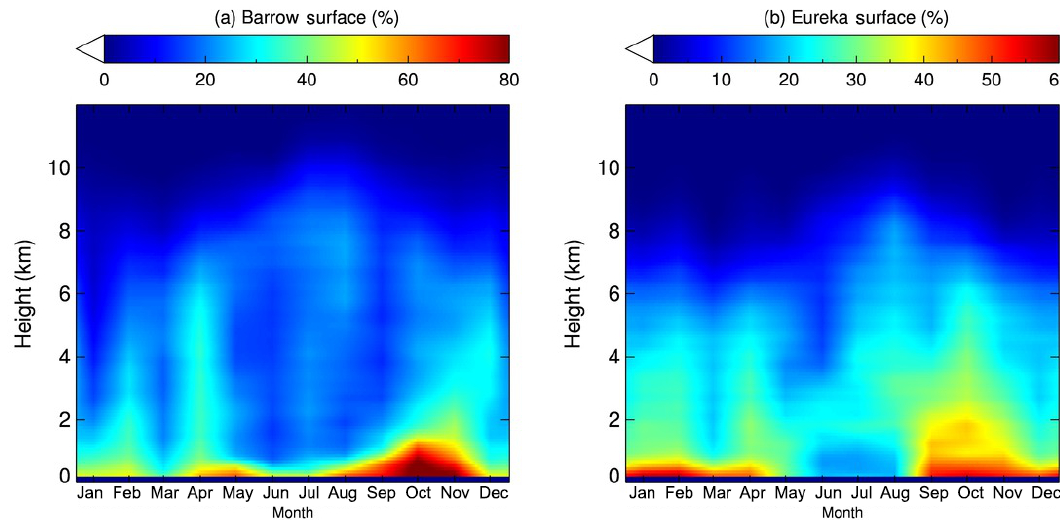
Figure 1. Cloud fraction vertical distribution from surface observations at (a) Barrow and (b) Eureka for 2006–2010 (after Shupe et al.,